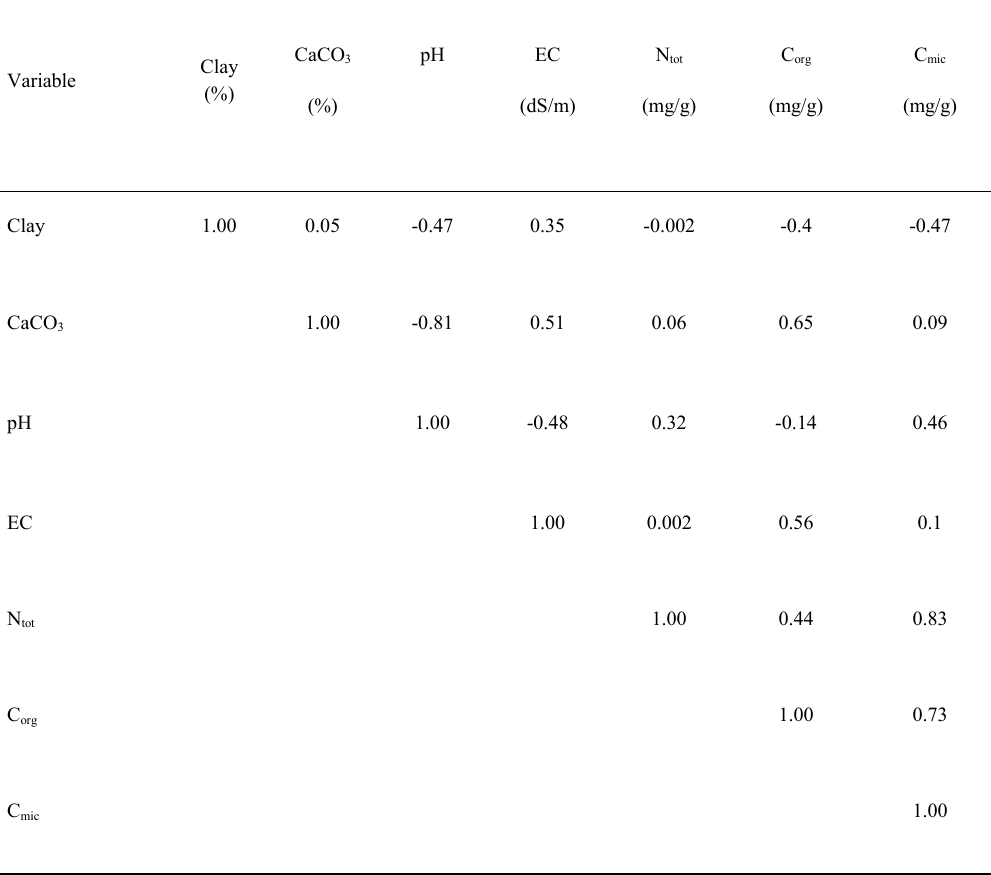
Table 2: Pearson correlation coefficients (r) among measured variables in polluted